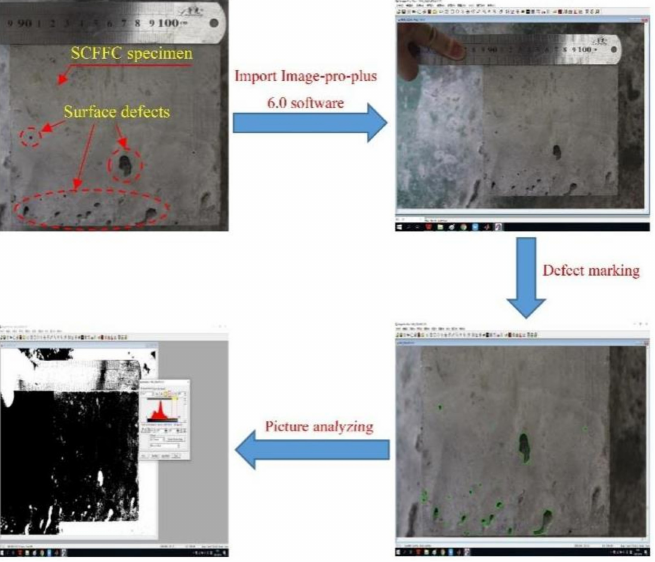
Figure 11. Apparent defect statistics of